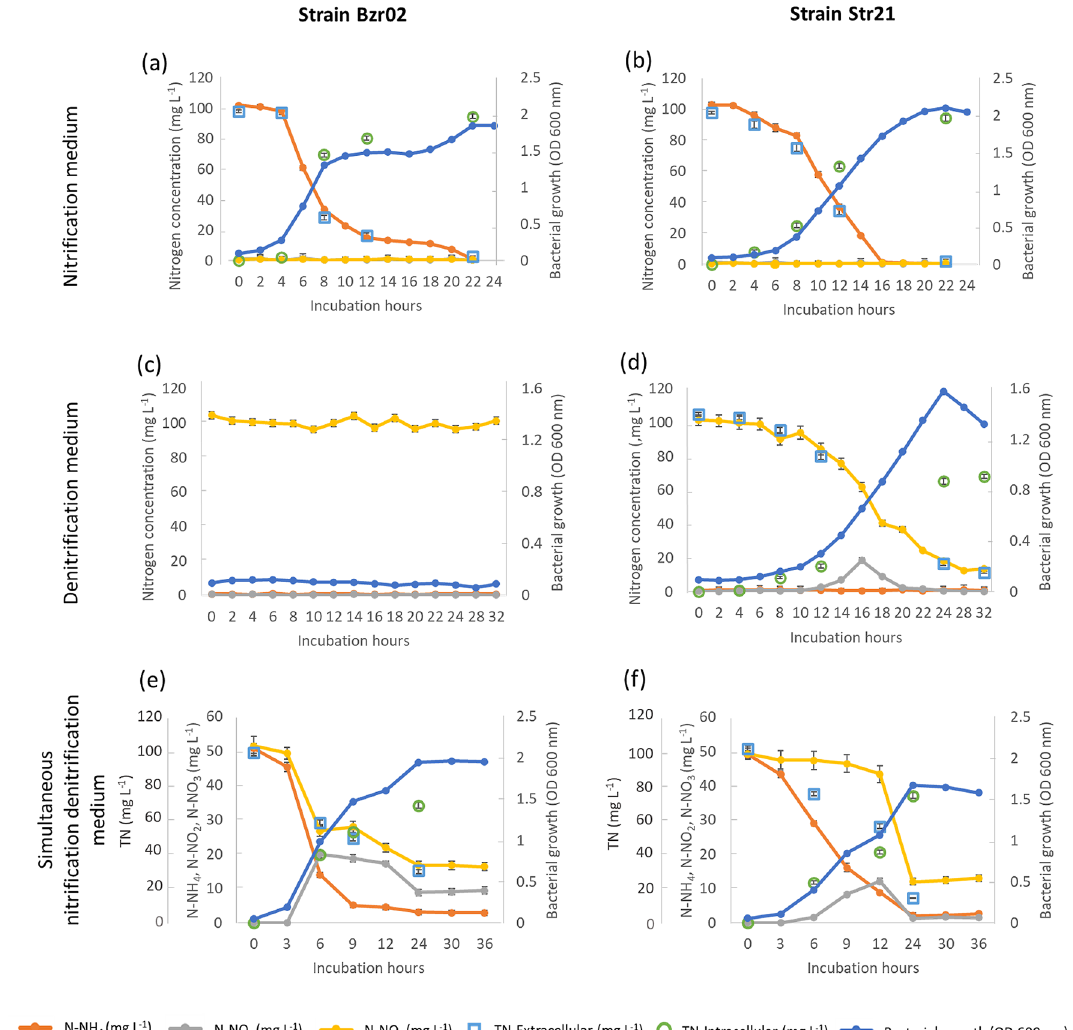
Figure 2. Dynamics of nitrogen transformation for strains Bzr02 and Str21 in nitrifying medium NM ( a , b , respectively), denitrifying medium DM ( c , d , respectively) and simultaneous nitrifying-denitrifying medium SNDM ( e , f , respectively). Values represent the mean and the standard error (n = 3).